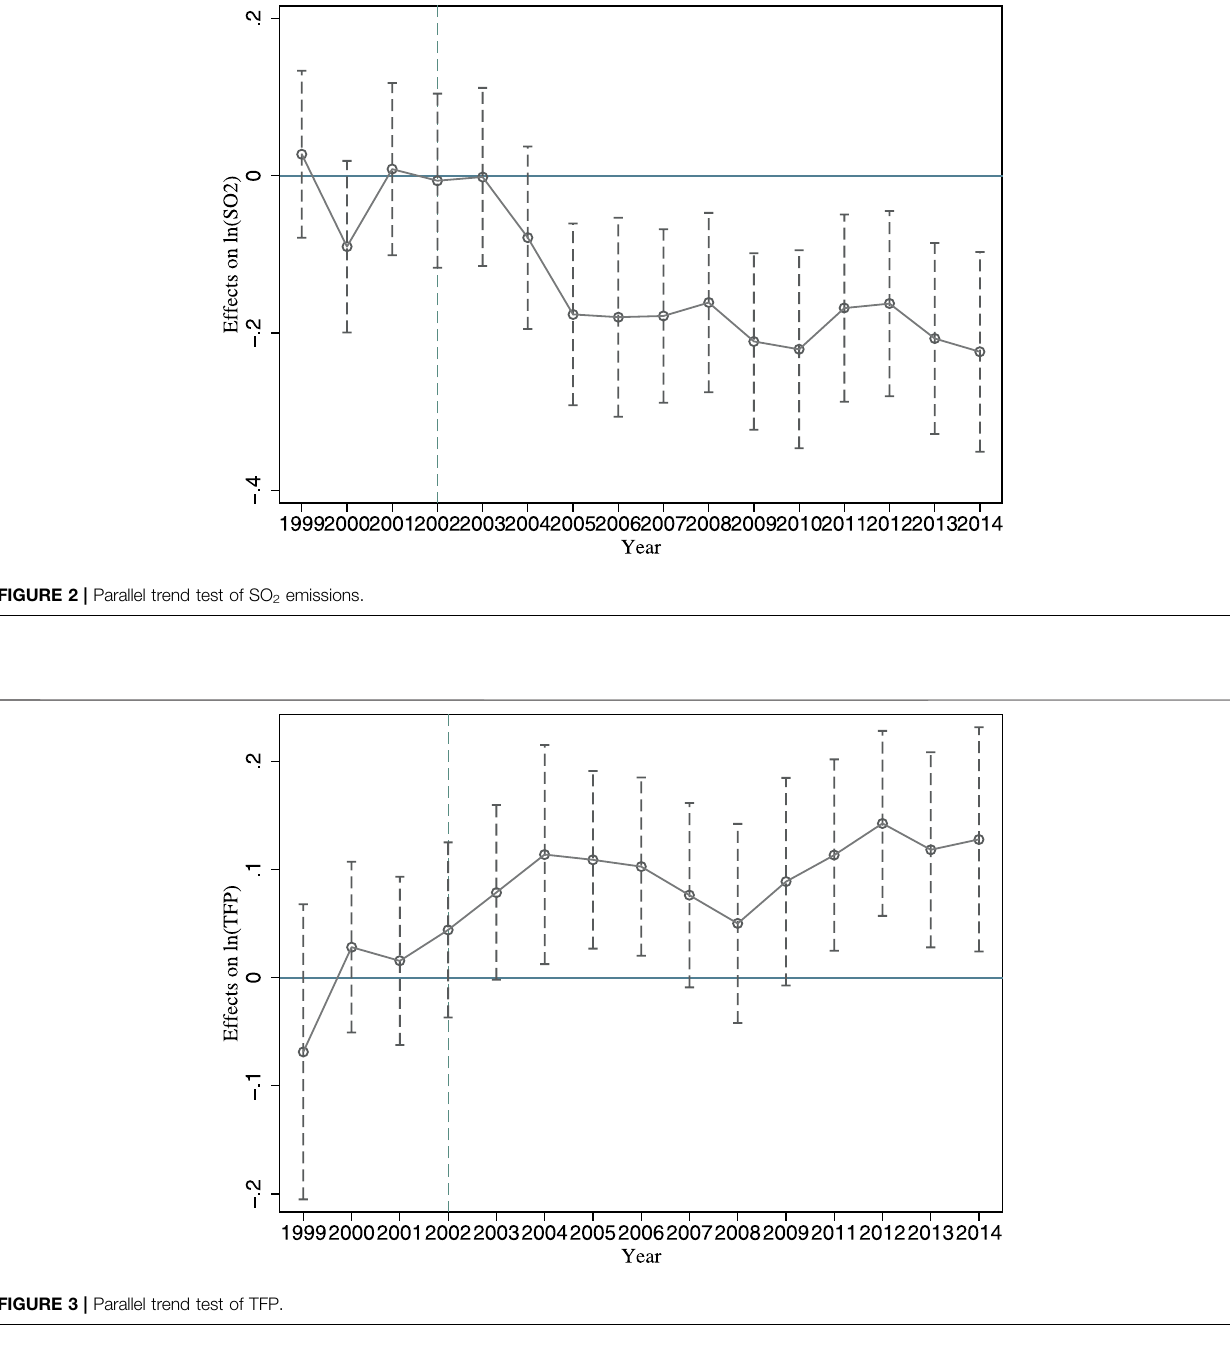
FIGURE 3 | Parallel trend test of